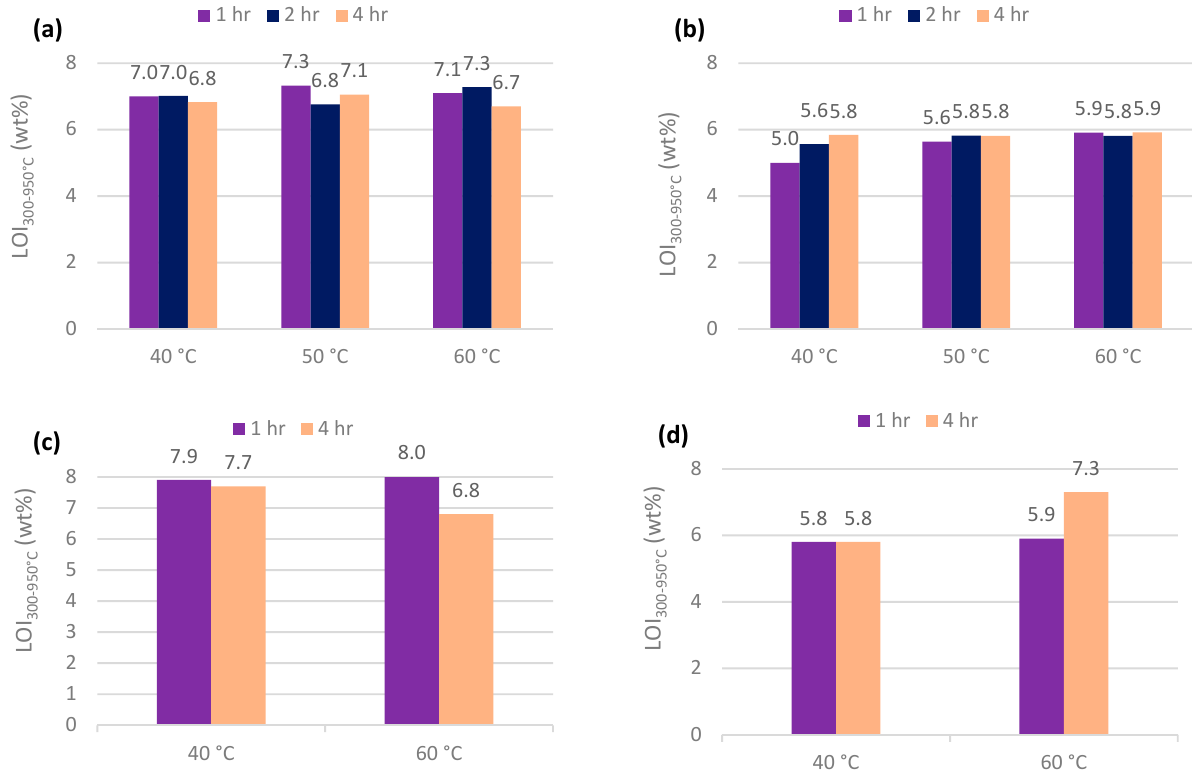
Figure 5. CO 2 content (LOI 300–950 ◦ C ) of slurry carbonated ( a ) kimberlite and ( b ) heat treated kimberlite in ultrapure water and ( c ) kimberlite and ( d ) heat treated kimberlite in 0.64 M NaOH. CO 2 content (LOI 300–950 ◦ C ) of unreacted kimberlite and heat-treated kimberlite are 7.3 and 4.7 wt%, respectively.